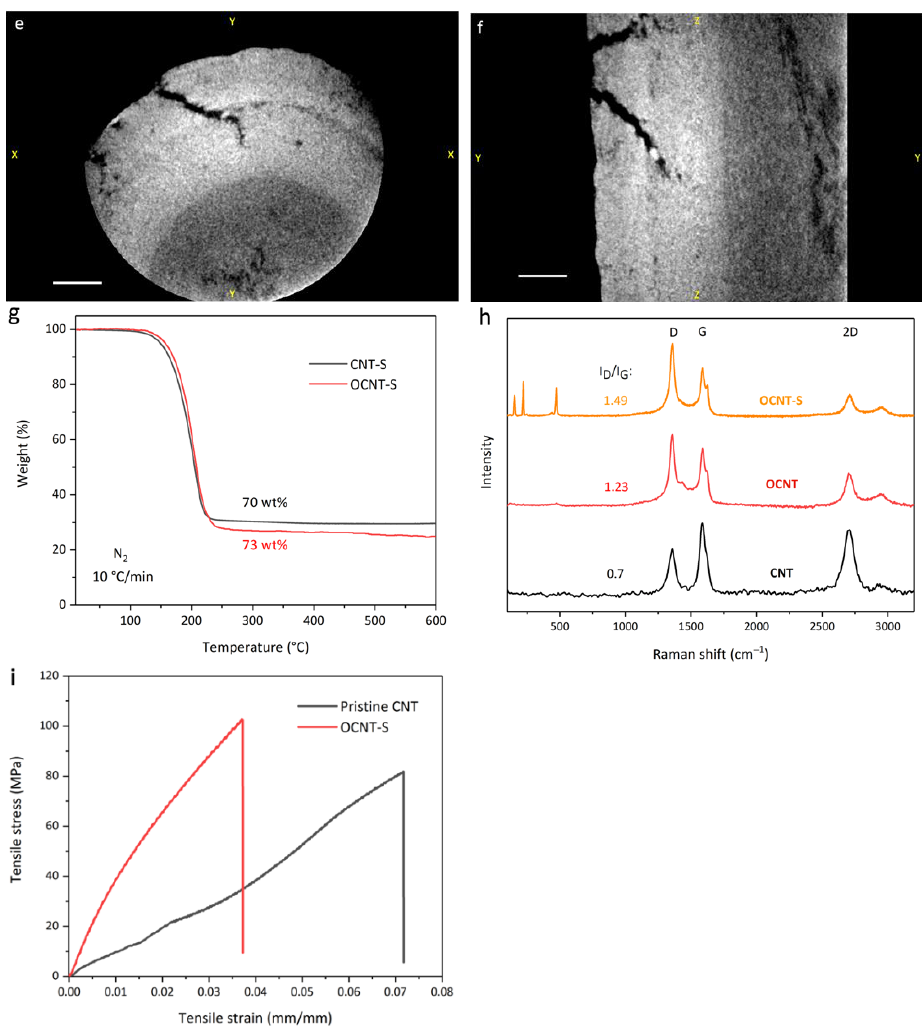
Figure 1. Low magnification SEM images of ( a ) OCNT-S, ( b ) CNT-S. High magnification SEM images of ( c ) OCNT-S, ( d ) CNT-S. The scale bars in the SEM images for ( a , b ) are 20 µm, and for ( c , d ) are 5 µm. ( e ) X-ray CT images of OCNT-S in XY slice. ( f ) X-ray CT images of OCNT-S in YZ slice. Scare bars for both ( e , f ) are 10 µm. ( g ) TGA curves for OCNT-S and CNT-S. ( h ) Raman spectra of CNT, OCNT, and OCNT-S, where characteristic peaks of sulfur were observed for CNT-S. The I D /I G ratios in all these samples are indicated. ( i ) Tensile stress vs. strain plot of pristine CNT and OCNT-S, respectively. The electrochemical performance of CNT-S and OCNT-S fiber electrodes measured at different current densities (0.1 C to 2 C) is shown in Figure 2. The capacities were calculated based on the mass of sulfur in the composite